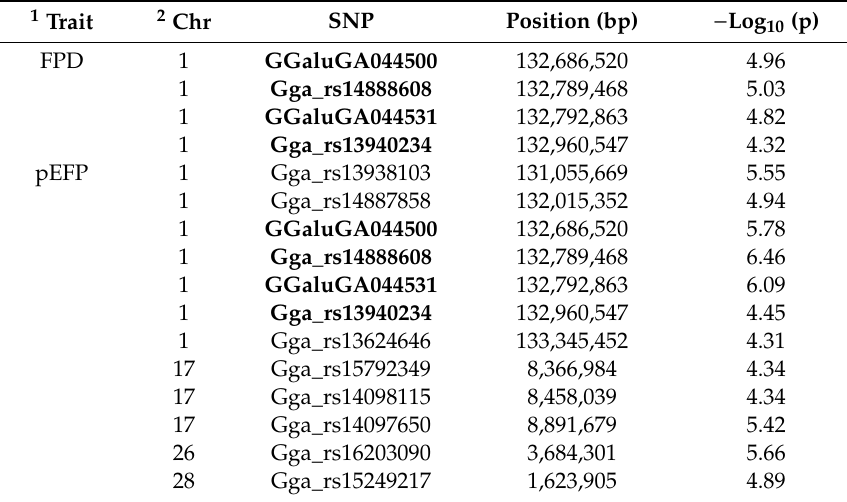
Figure 5. Mixture of negative binomial distribution (black lines) fitted to the feather pecking data (grey bars) in bouts per bird (bpb) of the high and low feather pecking hens (n = 492). The dotted line represents the fit of the feather pecking (FP) subgroup, the dot-dashed line represents the extreme feather pecking (EFP) subgroup and the solid line represents the combination of both and visualizes the good of fit of the mixture distributions. Table 1. Significant SNPs with p ≤ 5 × 10 − 5 from GWAS.